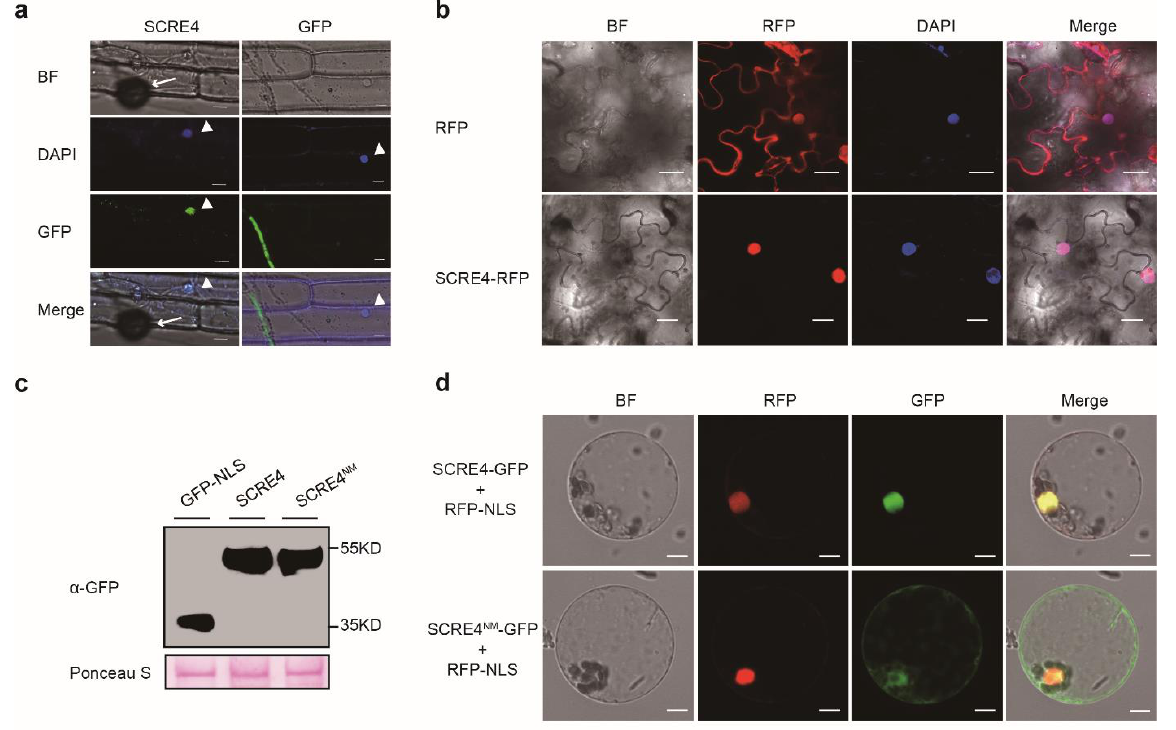
Figure 3. SCRE4 is internalized into plant cells during infection and is localized in nucleus. ( a ) Green fluorescence from SCRE4-GFP and GFP observed in rice cell nuclei during M. oryzae infection. The M. oryzae strains carrying pYF11- ProRP27:SCRE4-GFP and pYF11- ProRP27:GFP were inoculated onto detached rice sheaths. Green fluorescence was observed in epidermal cells of rice sheaths at 42 h after inoculation. BF, bright field; DAPI, the nuclei were stained with the dye DAPI; GFP, green fluorescent protein; Merge, the overlay of BF, GFP and DAPI images; Cell nuclei are indicated by white triangles, and appressoria are indicated by white arrows. Scale bar = 5 μm; ( b ) The subcellular localization of SCRE4-RFP and RFP expressed in Nicotiana benthamiana cells. SCRE4-RFP was transiently expressed in N. benthamiana leaves through Agrobacterium -mediated transient expression. The images were captured at 48 h after agro-infiltration under confocal microscopy. BF, bright field; RFP panels, red fluorescence from SCRE4-RFP; DAPI panels, the nuclei were stained with the dye DAPI; Merge, the overlay of GFP and DAPI images; Scale bar = 20 μm. ( c ) The expression of SCRE4-GFP and SCRE4 NM -GFP in rice protoplasts detected by immunoblotting with anti-GFP antibody ( α -GFP). Protein loading is indicated by Ponceau S staining. ( d ) Subcellular localization of SCRE4-GFP and SCRE4 NM -GFP expressed in rice protoplasts. RFP-NLS was transiently co-expressed with SCRE4-GFP or SCRE4 NM -GFP in rice protoplasts. GFP and RFP signals were visualized under confocal microscope. RFP-NLS was used as a marker for nuclear localization. Scale bar = 7.5 μm.